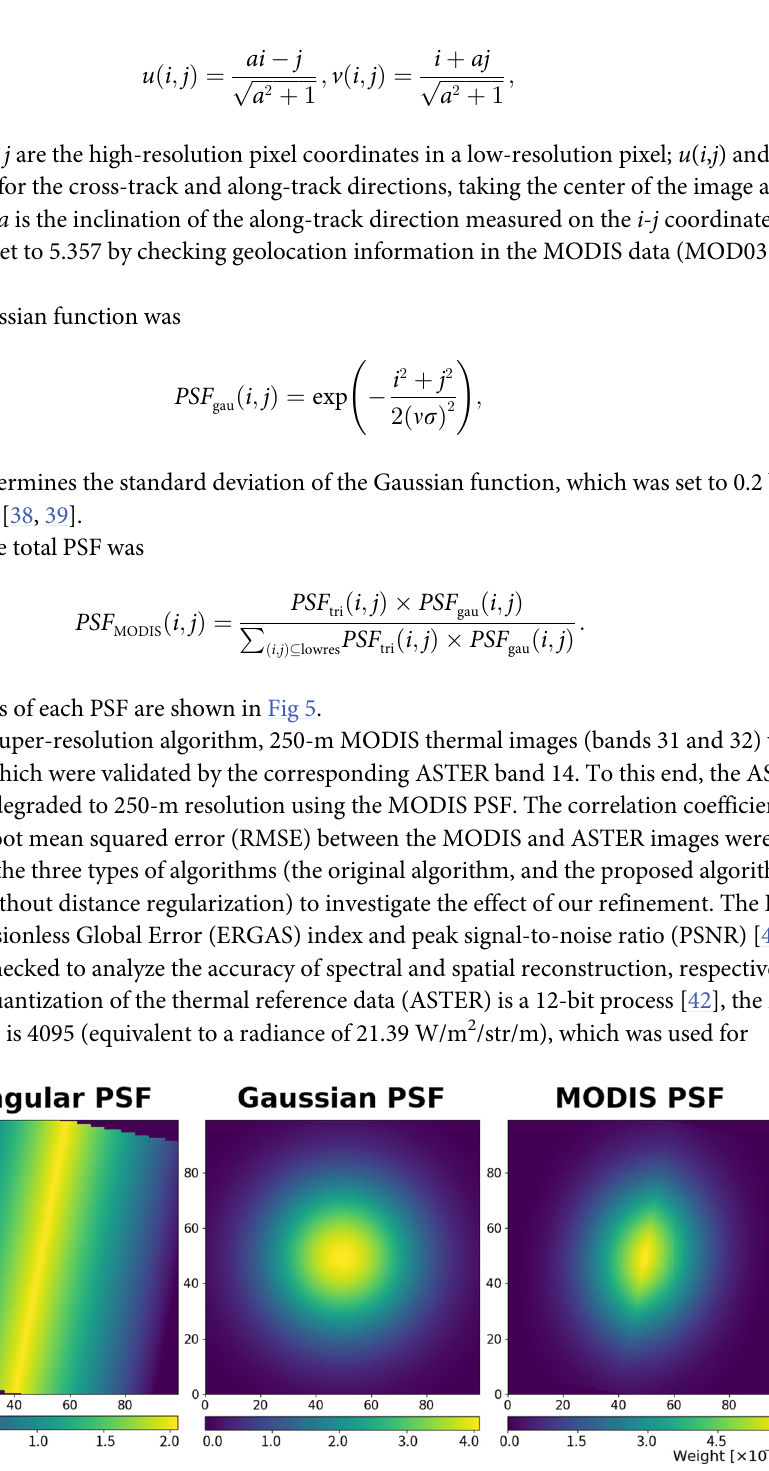
Fig 5. Simulated Point Spread Function (PSF) for 100 × 100 pixels (i.e., ν = 100). (left) Triangular weighting function for sensor PSF, (center) Gaussian weighting function for optical PSF, and (right) combined PSF for a Moderate Resolution Imaging Spectroradiometer (MODIS)